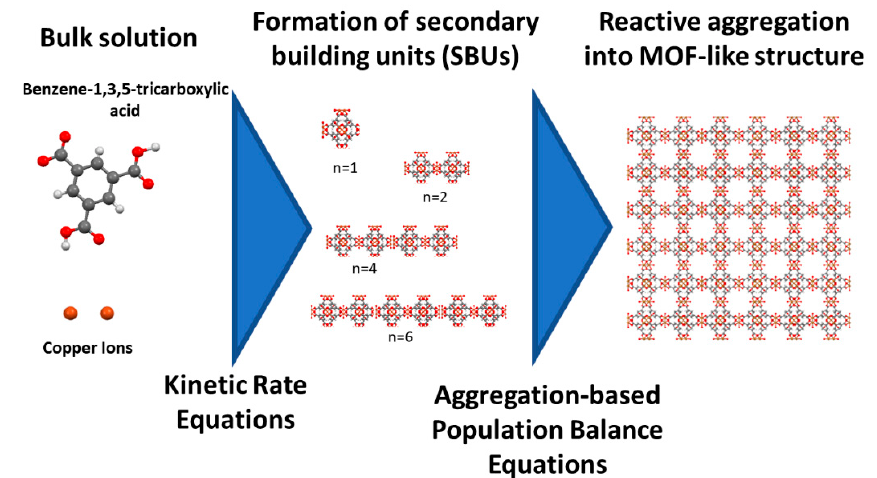
Figure 1. Schematic describing the mechanism and modeling approach for the synthesis of metal– organic frameworks (MOFs). In the case of copper trimesate (HKUST ‐ 1) MOF, the formation of secondary building units (SBUs) is modeled using kinetic rate equations and the resulting steady ‐ state distribution is supplied as an initial condition to the aggregation ‐ based population balance equations to obtain the distribution of MOFs.